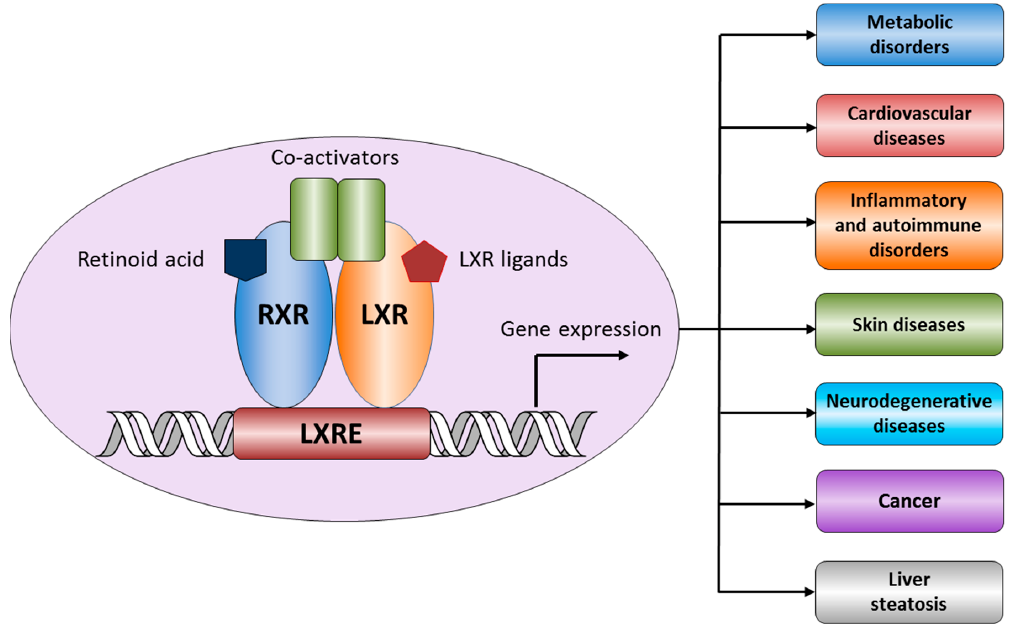
Figure 1. Liver X Receptors may be related to various pathological conditions.